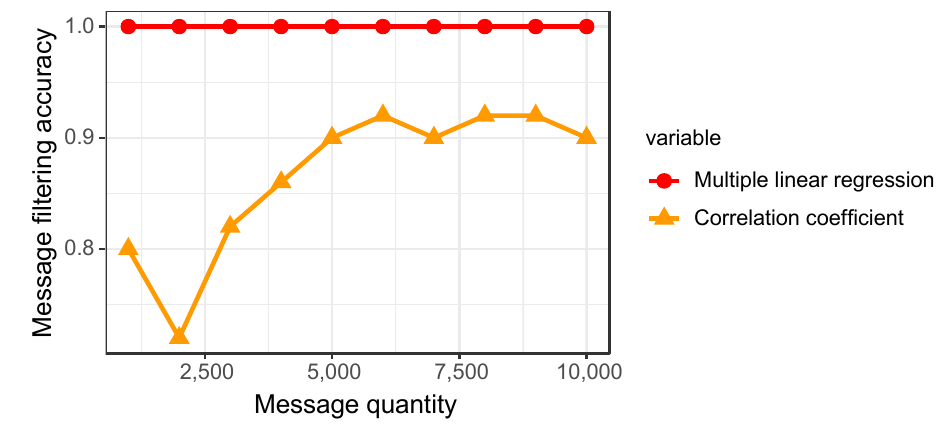
Figure 20. Comparison between correlation coefficient and multiple linear regression.